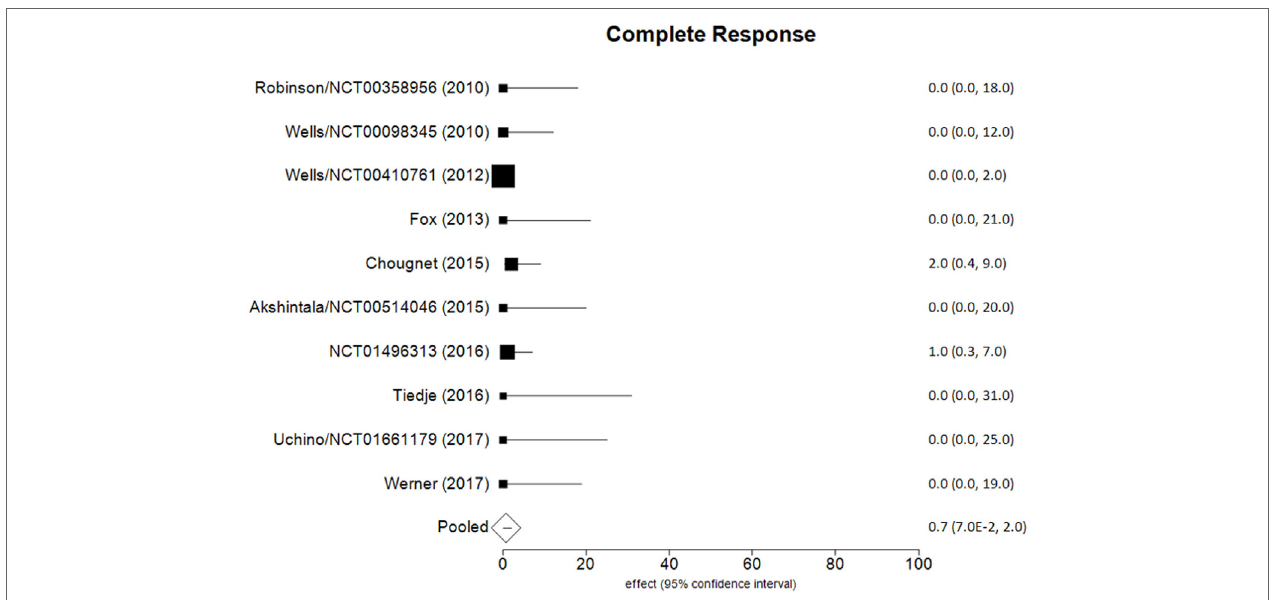
FigURe 2 | Forest plot of data on complete response (fixed effect).